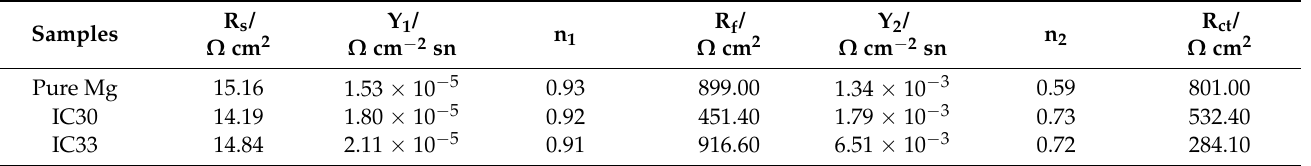
Table 4. EIS-simulated values of alloys.